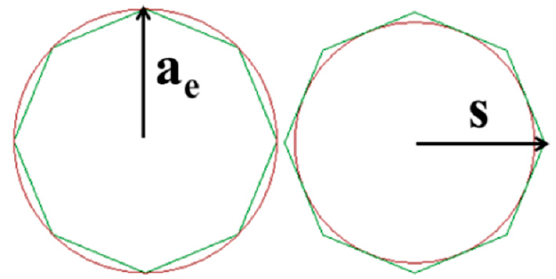
Figure 1. Area correlation between circular and octagon geometry.